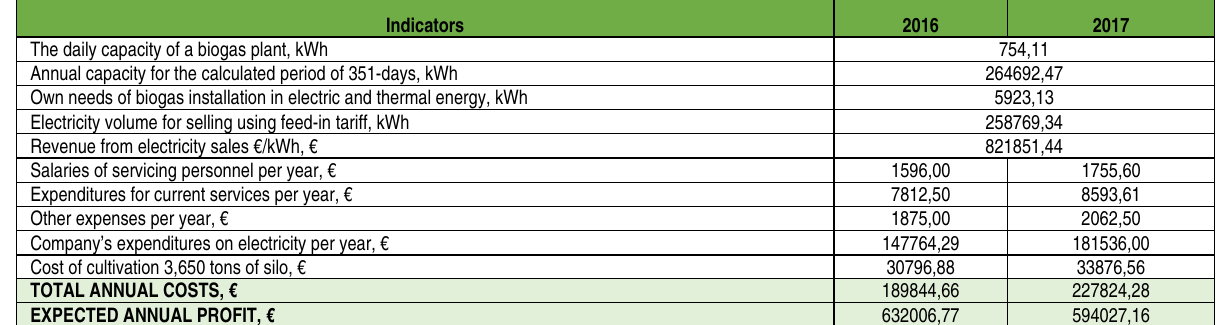
Table 8. The findings for the first scenario for years 2016–2017